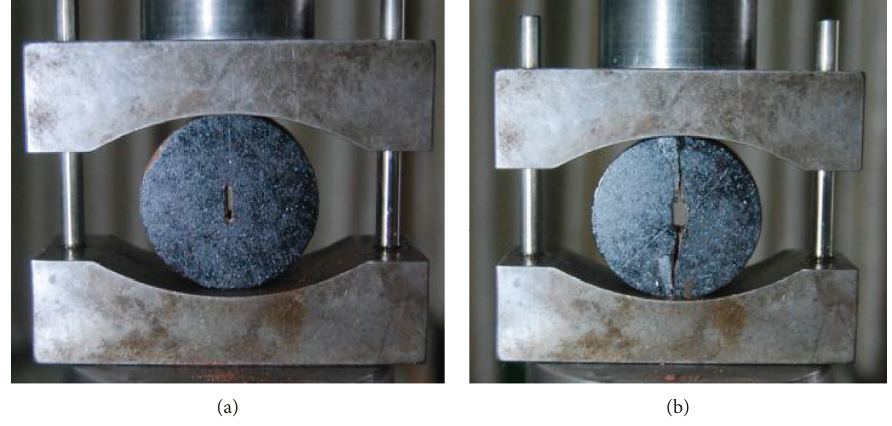
Figure 10: The pictures in cracked Brazilian test. (a) Before rock failure. (b) After rock failure.